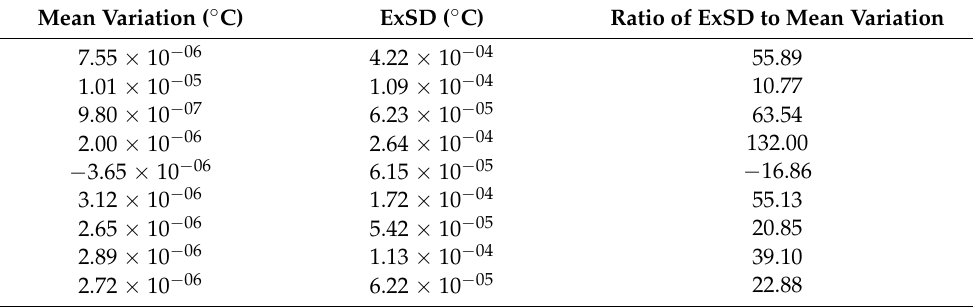
Table 4. The ratio of Standard Deviation to Mean of temperatures.